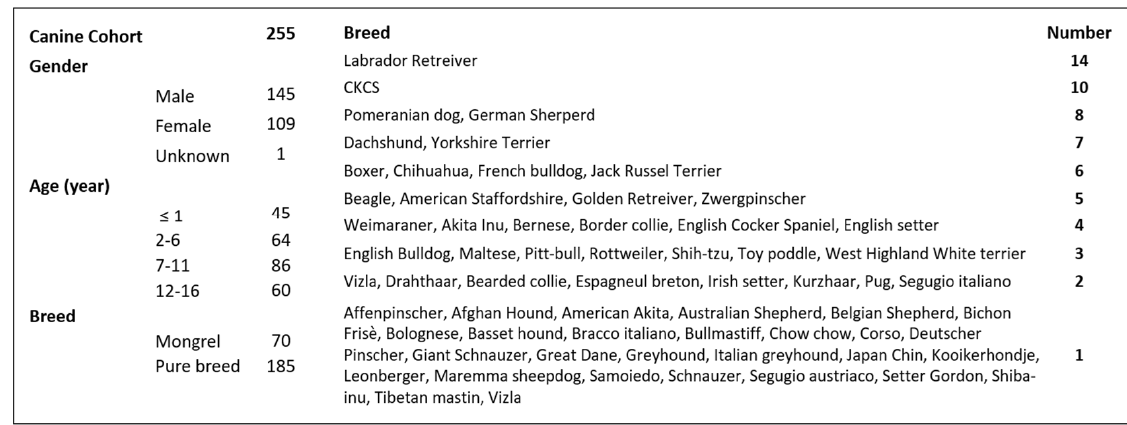
Figure 1. Details of overall canine cohort studied including list of breeds. Males and pedigree dogs were over-represented.